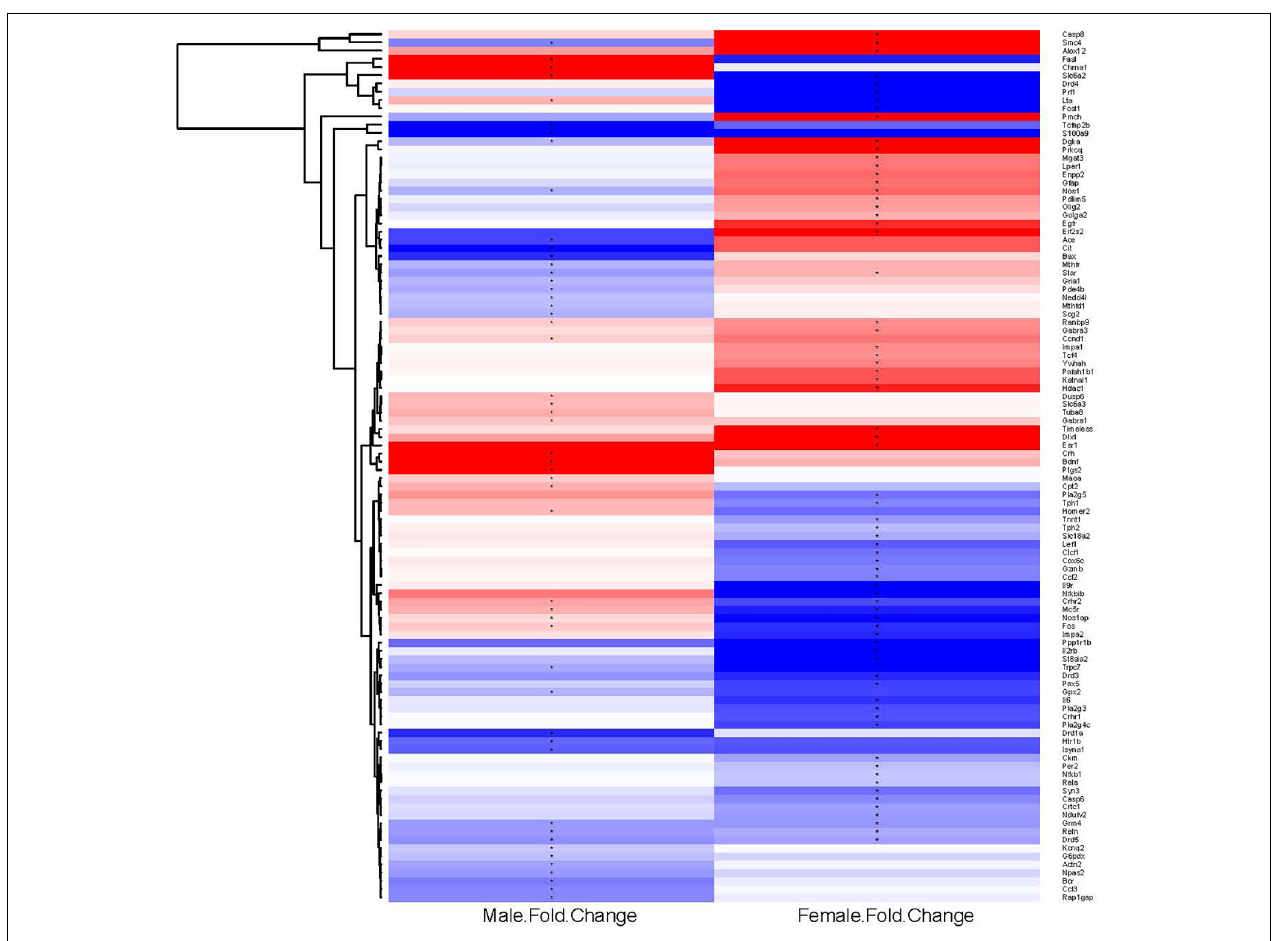
FIGURE 2 | Heat map and hierarchical cluster analysis of genes significantly regulated by repeated binge drinking in male and female mice. All significantly regulated genes (106 total) were used to generate the heat map and to perform the cluster analysis to visualize the transcriptional response at 24 h after the 7th binge ethanol drinking session. Each column represents the combined data from six arrays (three binge, three control), with the binge ethanol-induced change in expression shown for males and females in separate columns. Shades of color indicate up-regulation (red) or down-regulation (blue) for a particular gene following binge drinking. Hierarchical cluster analysis was performed on the ethanol regulated genes. Genes (represented by rows, names at the right of the image) were clustered according to the similarity of expression profile as the result of repeated binge drinking. Clustering of genes emphasizes the sexually dimorphic response to repeated binge drinking experience. ∗ p < 0.05 for significantly regulated genes (binge vs.